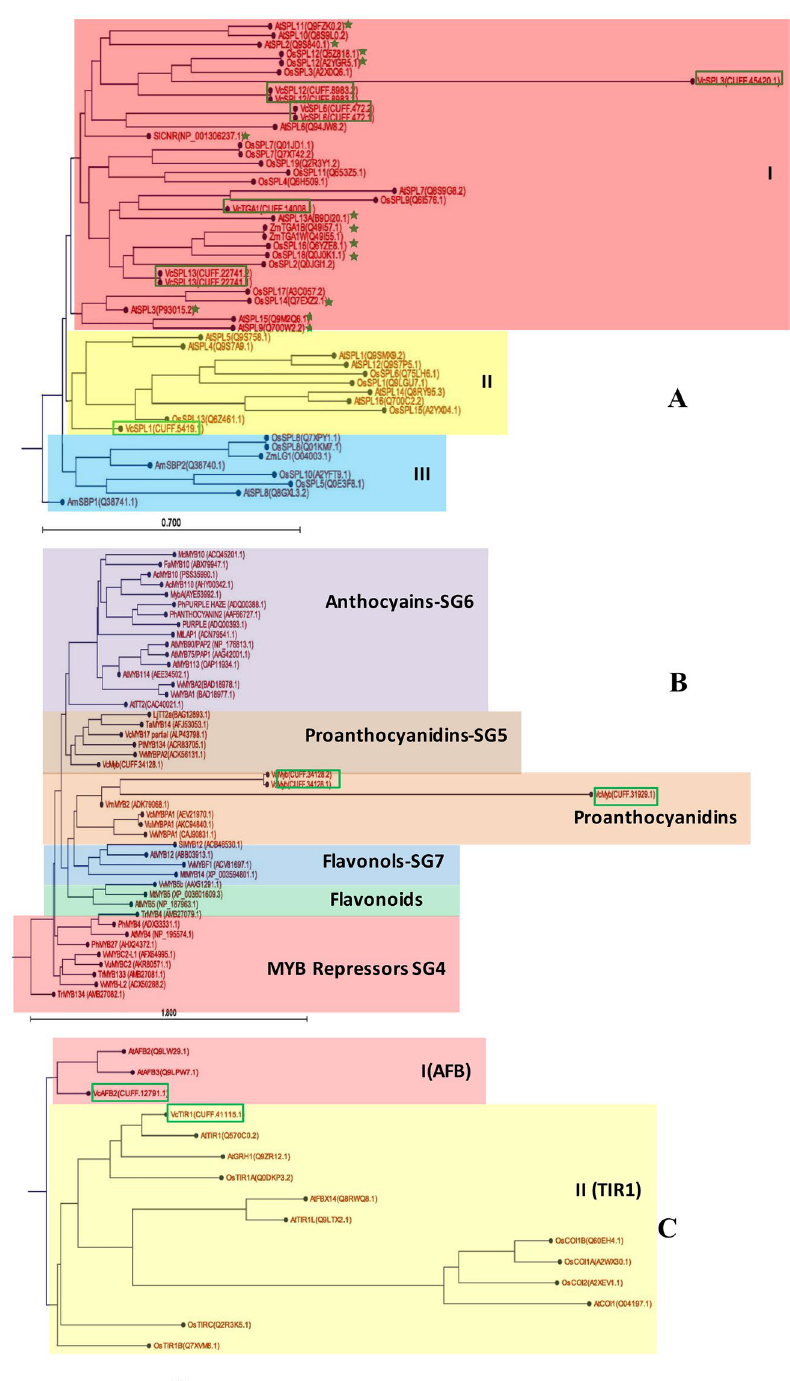
Figure 3. Phylogenetic tree of SPLs (A) , TIR1/AFBs (B) and MYBs (C) based on their deduced proteins. The SPLs were divided into group I in red, group II in yellow, and group III in blue. VcSPL in blueberry were branched into group IV and included a number of representative SPLs. The corresponding SPL genes in clades with asterisks were regulated by miRNA156, e.g. OsSPL2, OsSPL12, OsSPL13, OsSPL14, OsSPL16, and OsSPL18 in rice 39 , ZmTGA1 in maize 40 , AtSPL3 in Arabidopsis 41 , AtSPL2, AtSPL3, AtSPL9, AtSPL10, AtSPL11, AtSPL13A, AtSPL15 42 , and SlCNR in tomato 22 ; TIR1/AFBs were divided into group I (AFB) in red, and group II (TIR1) in yellow. VcTIR1 (CUFF.41115.1), and VcAFB2 (CUFF.12791.1) were categorized into the two independent branches. VcMYBs unigenes (CUFF.34128.1, CUFF.34128.2, and CUFF.31929.1) were